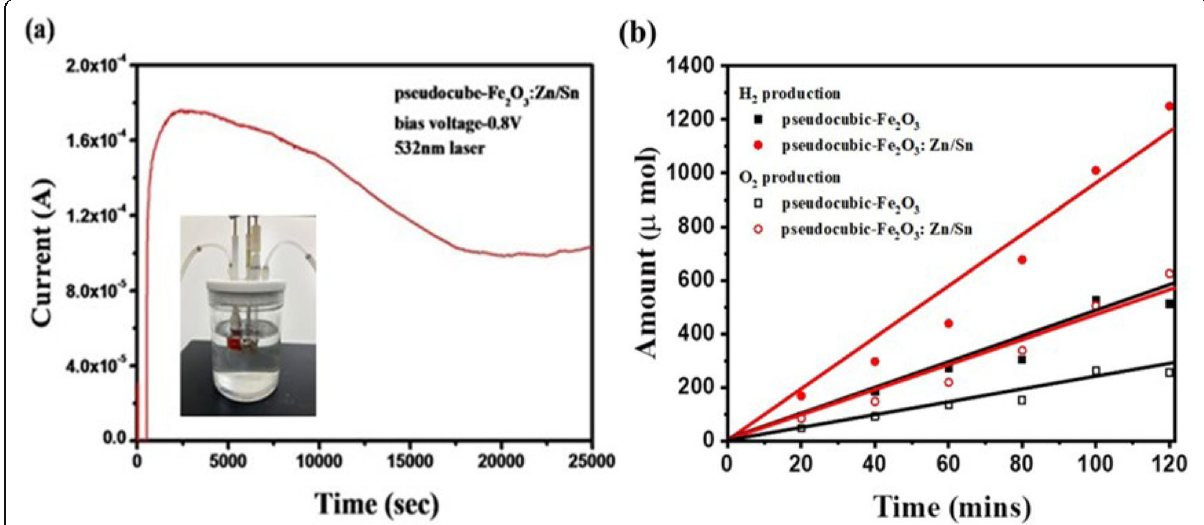
Fig. 6 a Stability study of pseudocubic Fe 2 O 3 :Zn/Sn photoelectrodes (inset photo: our test system). b Production of H 2 and O 2 from pseudocubic Fe 2 O 3 :Zn/Sn